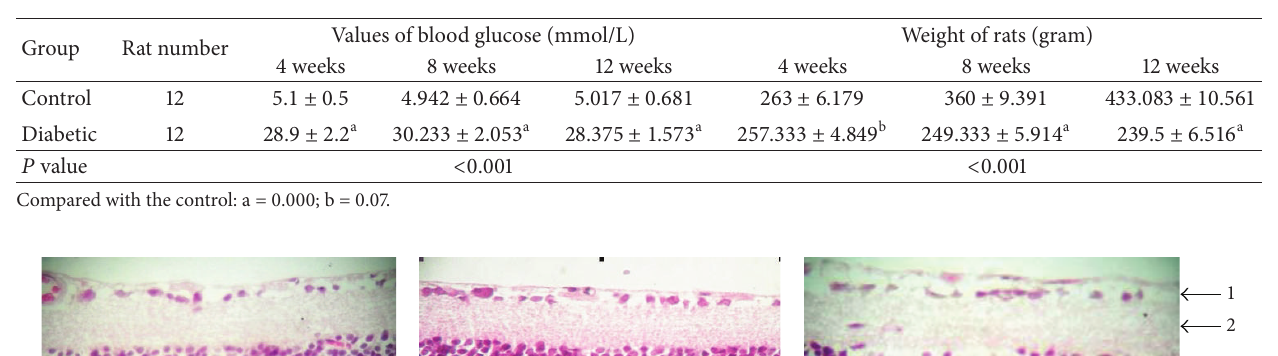
Table 1: Values of rat blood glucose and weight at 4, 8, and 12 weeks.